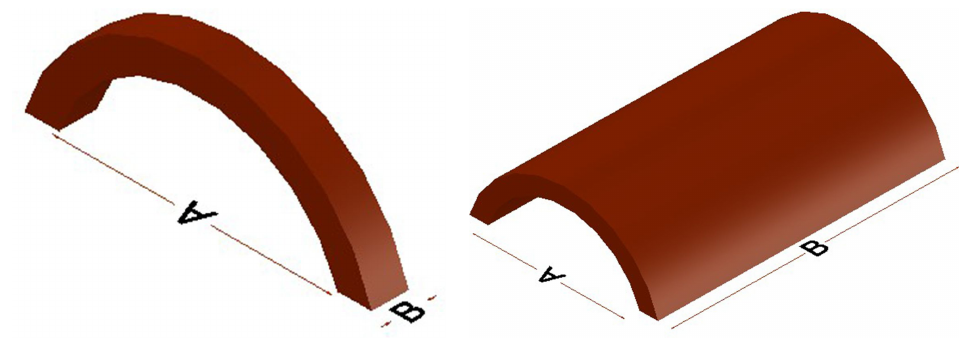
Figure 1: Comparison of vault and rib (authors). Vault=B > A & Rib=B < A